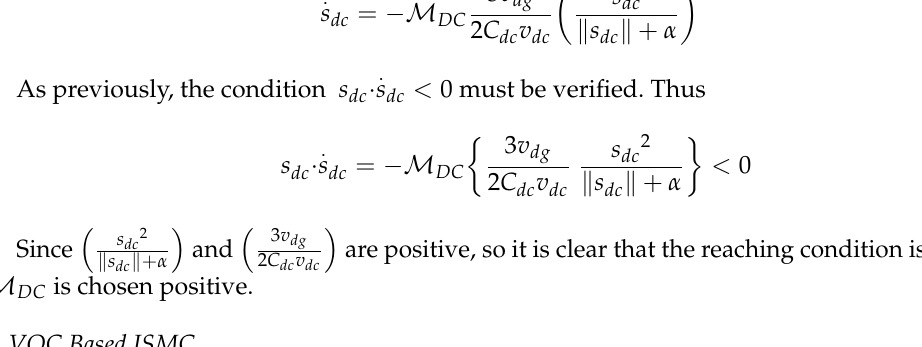
. Figure 9 summarizes the functionality of VOC-ISMC.